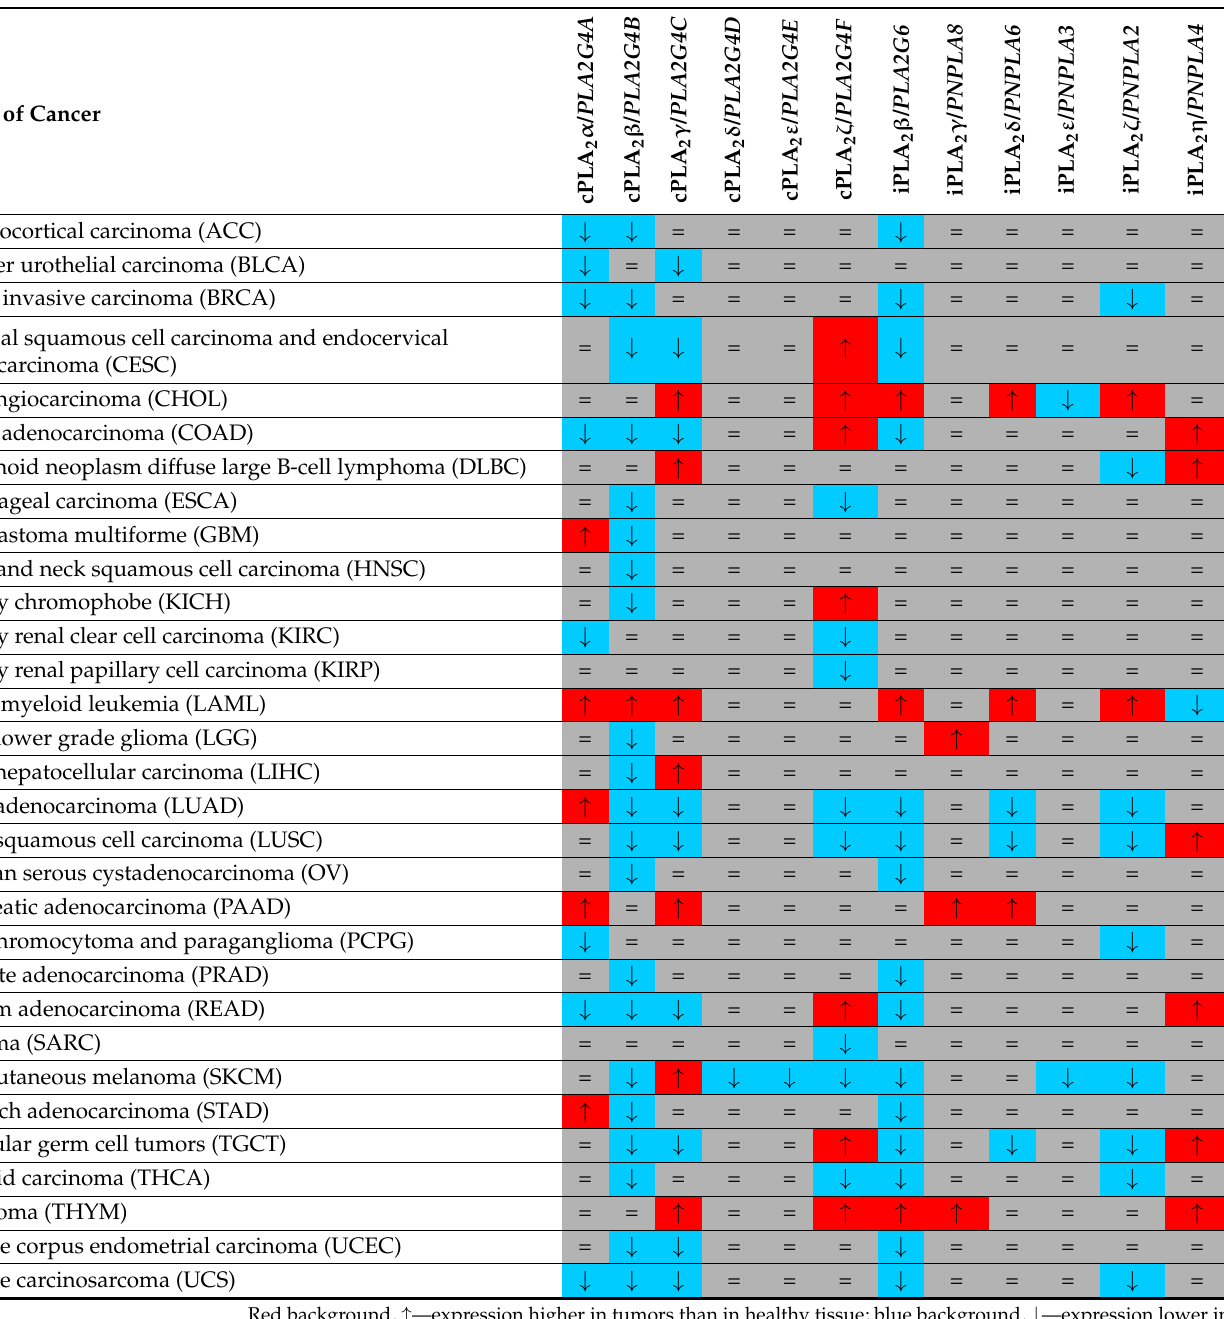
Table 3. Pan-cancer analysis of gene expression of cPLA 2 and iPLA 2